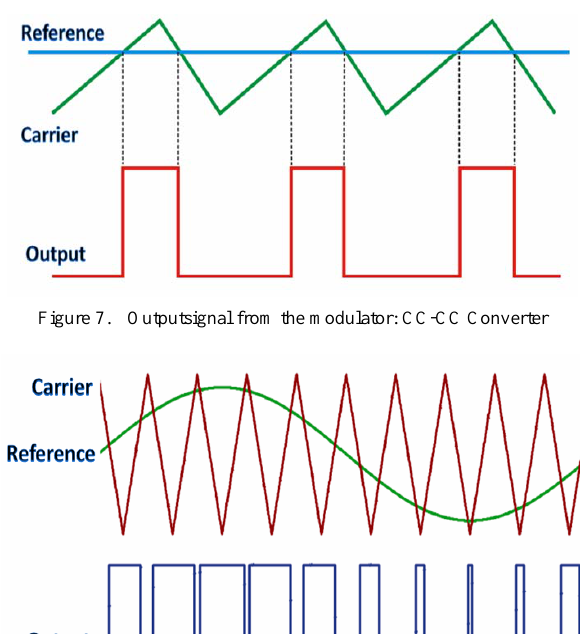
Figure 9. PWM remote experiment set up at the SATC college